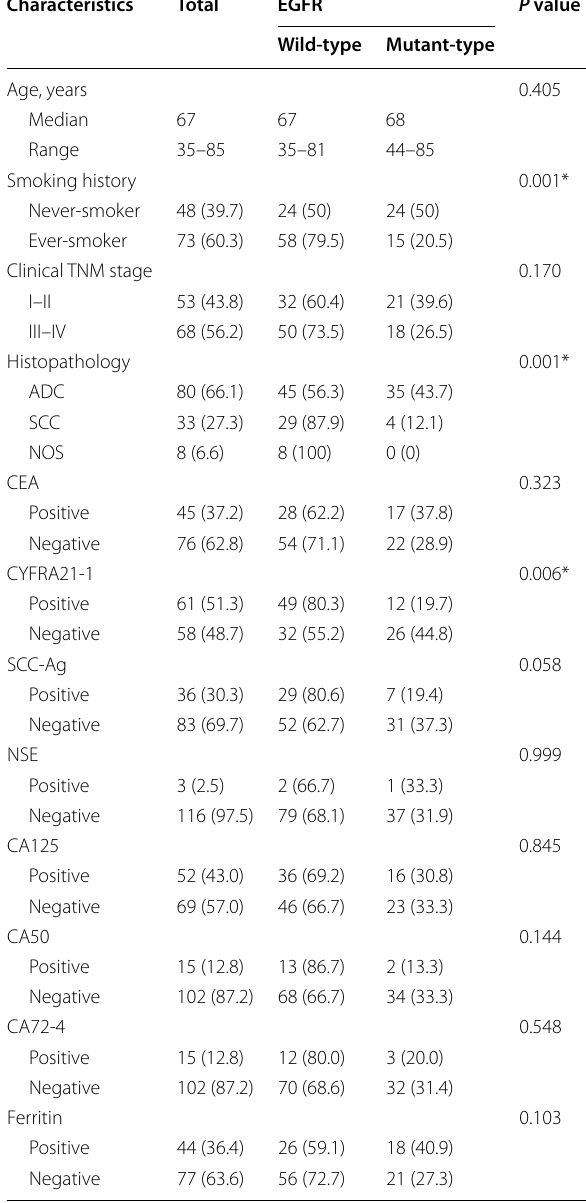
*Indicates significant differences between the comparison groups